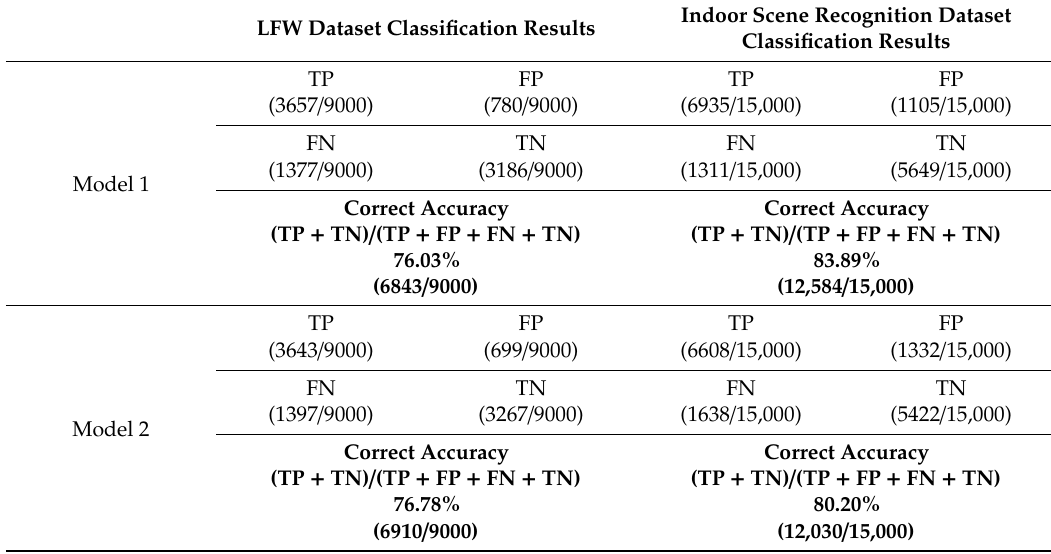
Table 3. Preference classification results from Model 1 and Model 2 with the Labeled Faces in the Wild (LFW) and Indoor Scene Recognition